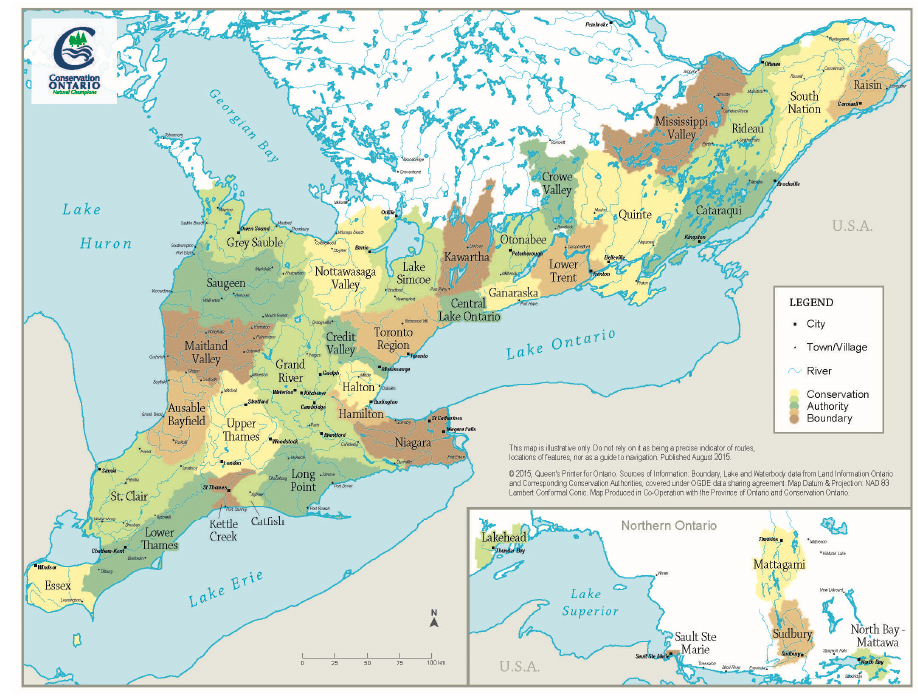
Figure 1. Conservation Authorities of Ontario (Conservation Ontario).